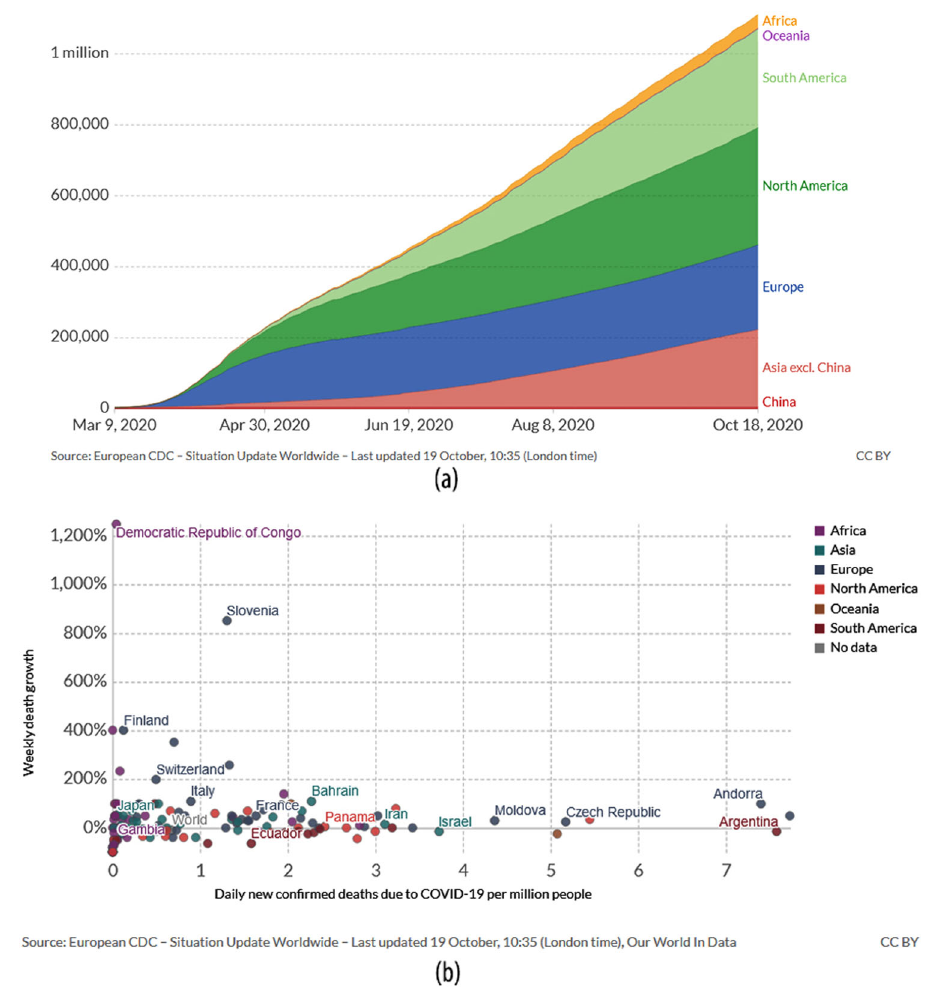
Fig. 3 Severity of pandemic COVID19 on different continents. Graphs showing ( a ) total con fi rmed deaths ( b ) weekly death growth rate vs. daily death rate till 19 October 2020. This fi gure is covered by the Creative Commons Attribution 4.0 International License as mentioned on Source: https://